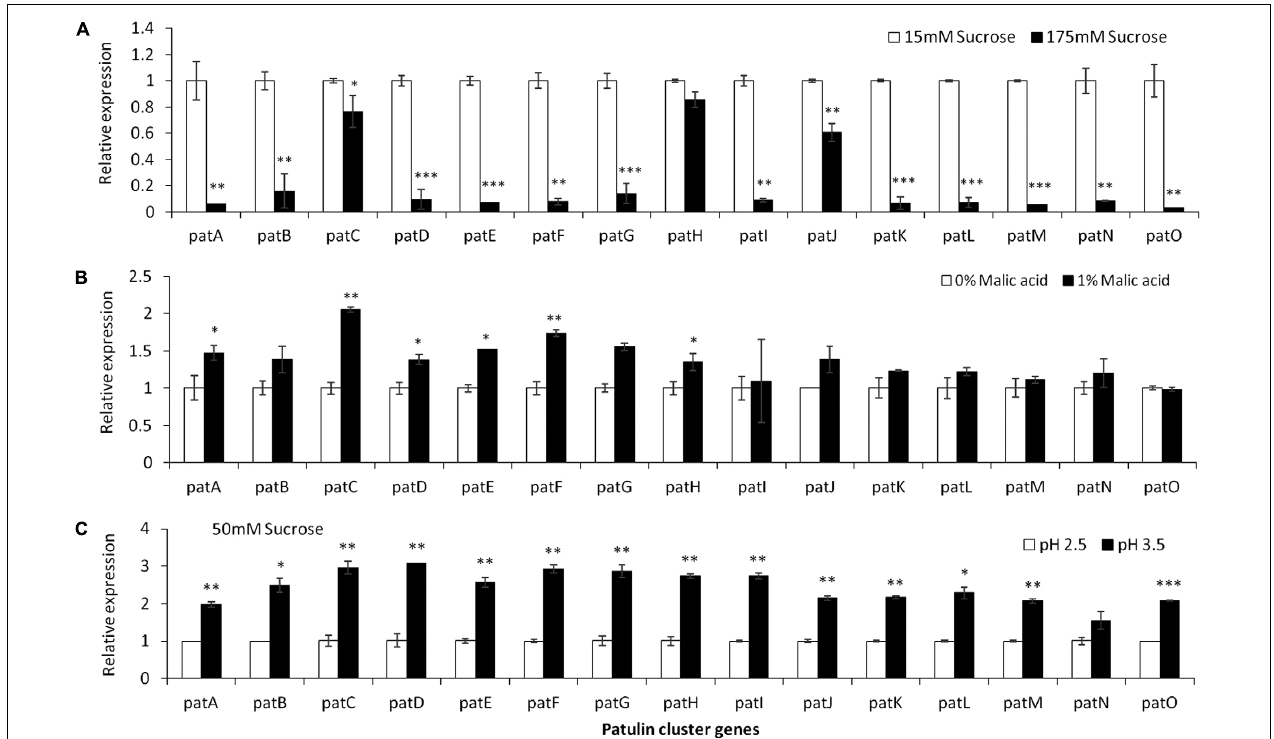
FIGURE 4 | pat genes cluster (PGC) relative expression as affected by sucrose and malic concentrations and pH levels. Solid SM media at initial pH 5.0 amended with sucrose (A) , malic acid (B) , and various pH (C) on SM solid media were compared. The media was inoculated with 100 µ l of a 10 6 spore/ml suspension and the relative expression patA, patB, patC, patD, patE, patF, patG, patH, patI, patJ, patK, patL, patM, patN, patO between treatments were compared. Expression was evaluated 3 days post-inoculation after the mycelia was sampled from the culture plates. Average values ( ± SE) of five replicates are reported. Experiments were repeated three times and results of a single representative experiment are shown. For statistical analysis, the unpaired student t -test was used with significance defined as a P value ( ∗ P ≤ 0.05; ∗∗ P ≤ 0.01; ∗∗∗ P ≤ 0.001).